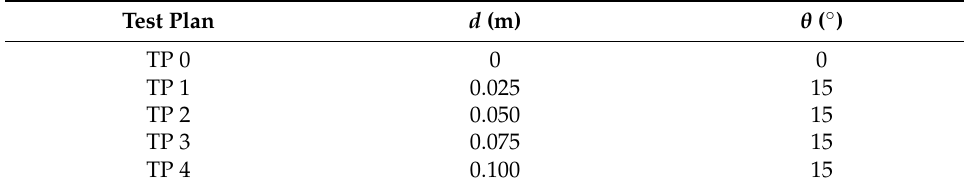
Table 4. Test plan of stilling basin with negative